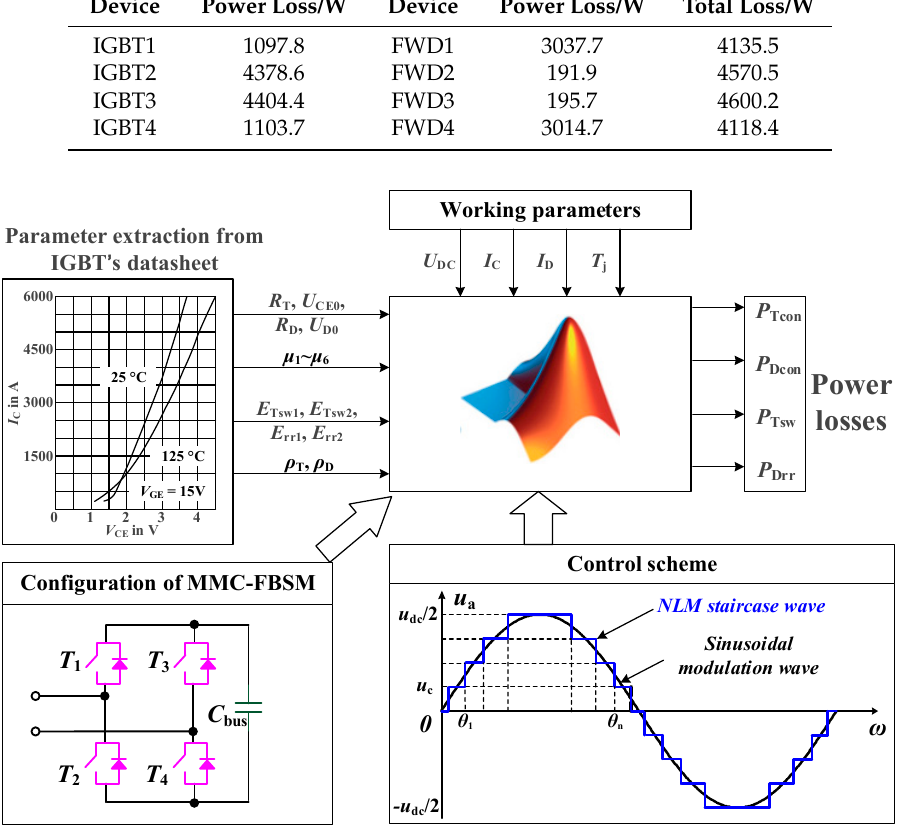
Figure 13. Power loss calculation procedure.